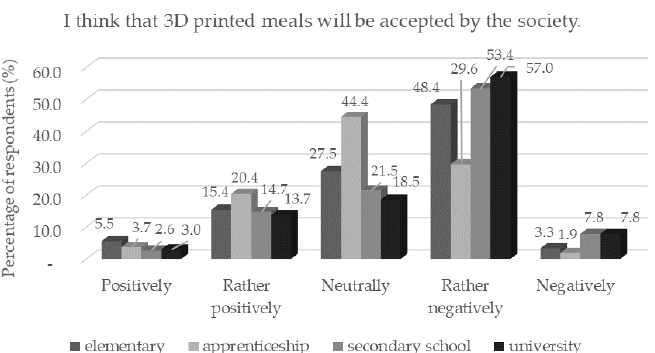
Figure 10. Respondents’ worries and understandings ( n = 1156) by education in response to the statement: “I think that 3D printed meals will be accepted by society.” Table 3. Three-Dimensional Food Printing, Worries and Understanding. Distribution of respond- ents (%).